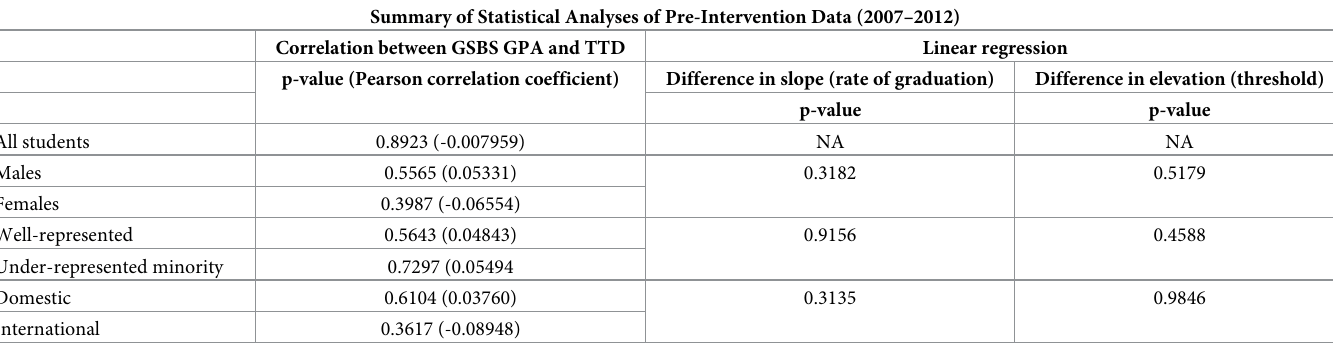
Table 3. Summary of statistical analysis regarding graduate GPA and time to